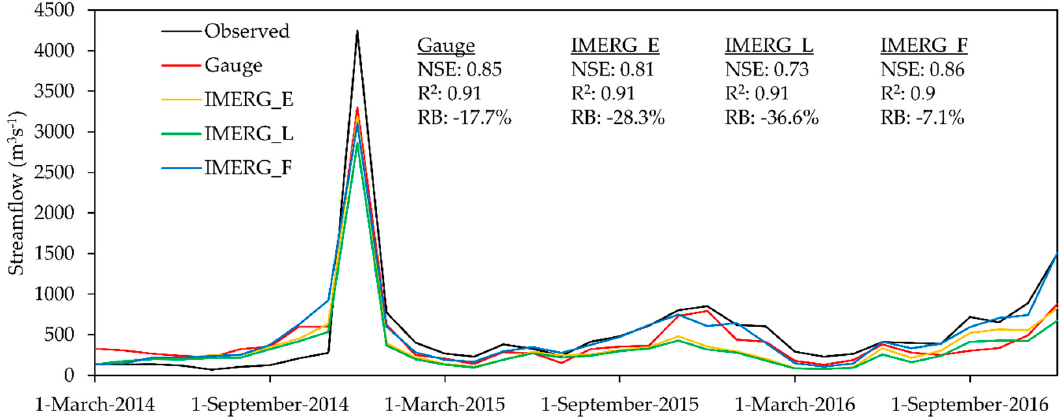
Figure 6. Statistical analysis of the GPM IMERG products in SWAT-simulated monthly at the Jambatan Guillermard from March 2014 to December 2016.